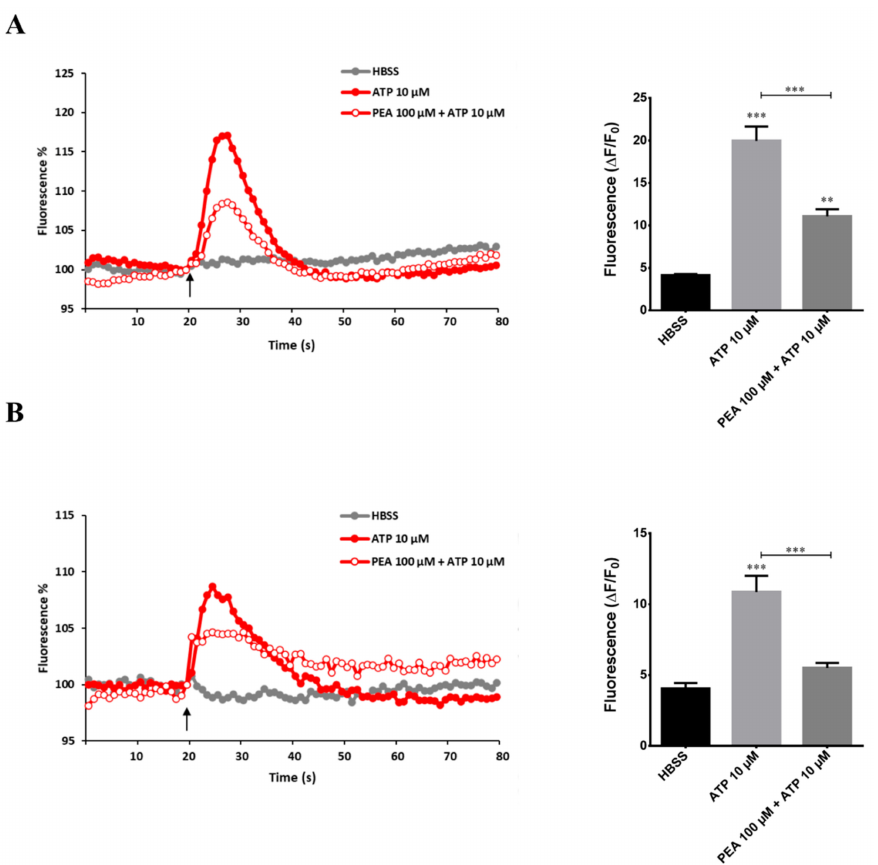
Figure 8. Effect of PEA on ATP-mediated intracellular Ca 2+ increase in primary microglia and N9 cells. Cells were loaded with FLUO-4 NW and fluorescence emission was measured at 535 nm every 0.5 s for the 20 s preceding and the 60 s following the injection of the stimuli. (left) ATP was injected in ( A ) N9 cells and in ( B ) primary microglia at the time indicated by the arrow. Results are the means of measurements obtained in at least six different wells for each experiment. All experiments were repeated at least three times. One representative experiment is shown (right). Graphs show intracellular Ca 2+ increase (expressed as fluorescence intensity) in ( A ) N9 cells and ( B ) primary microglia stimulated with ATP. Data are shown as the mean ± S.E.M. of measurements obtained in three independent experiments ( n = 18). Differences between groups were tested for significance by applying the ANOVA test and Tukey post hoc test. ** p < 0.01, *** p <